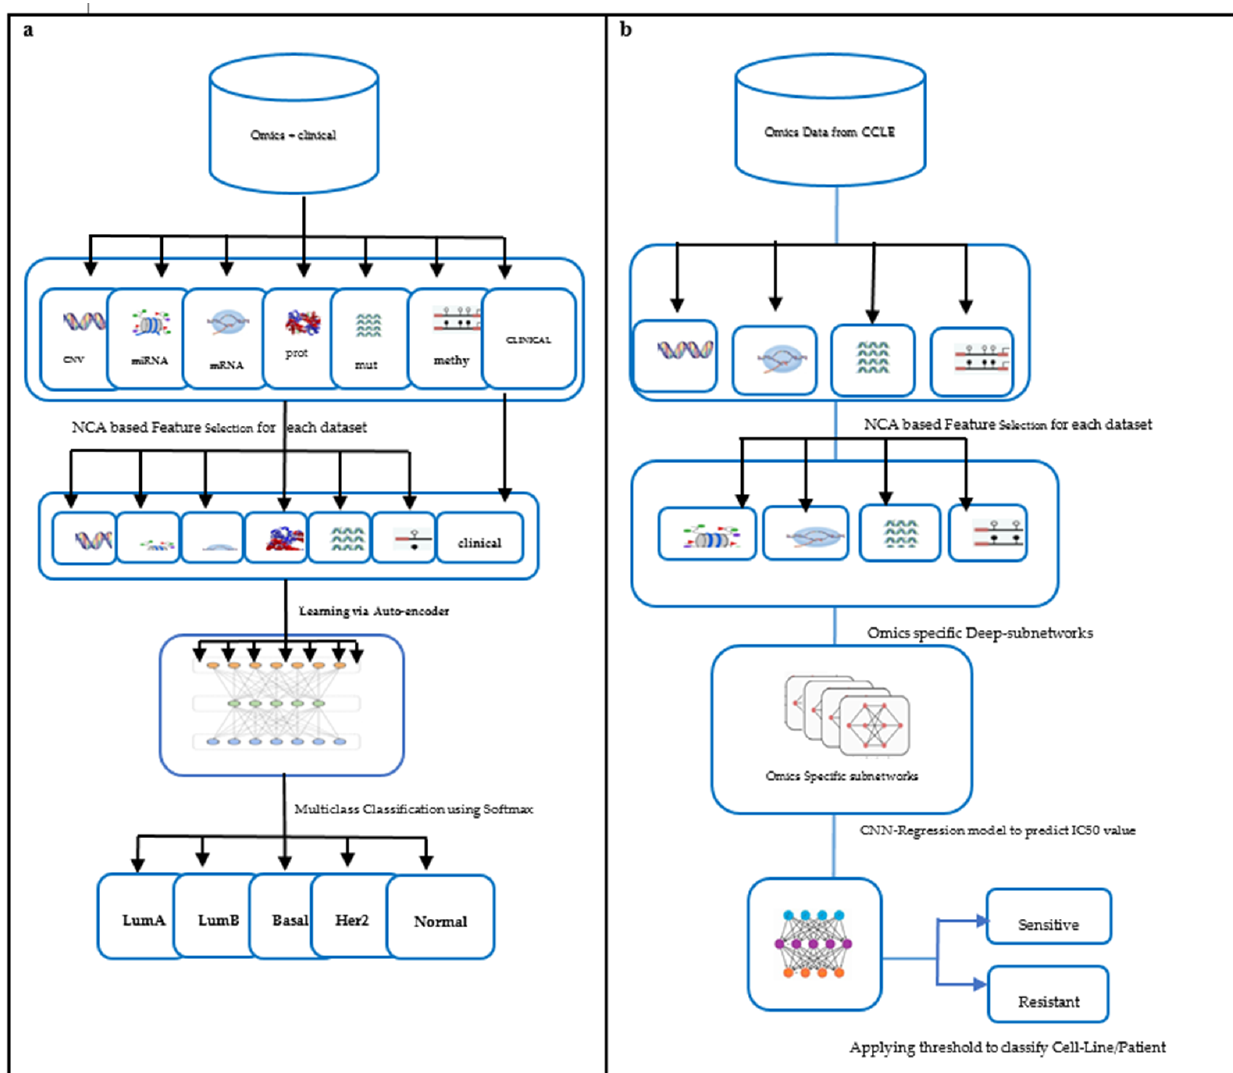
Figure 1. Framework for training predictive models: ( a ) Subtype classification. ( b ) Drug response prediction.